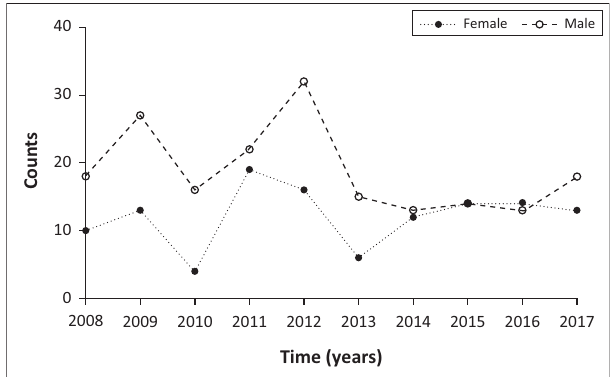
FIGURE 2: Trend of suicide by gender for the 2008–2017 decade.